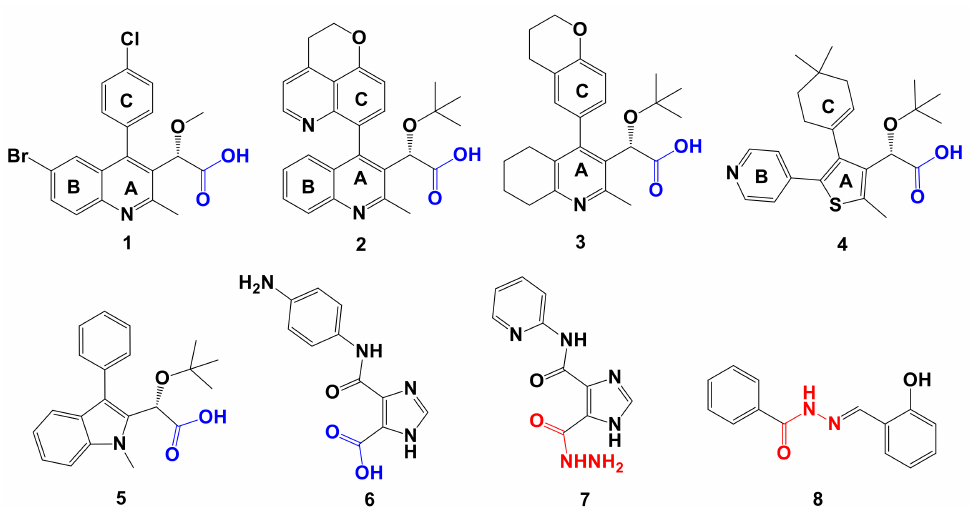
Figure 1. Structures of different of LEDGF/p75-IN inhibitors ( 1 – 8 ).